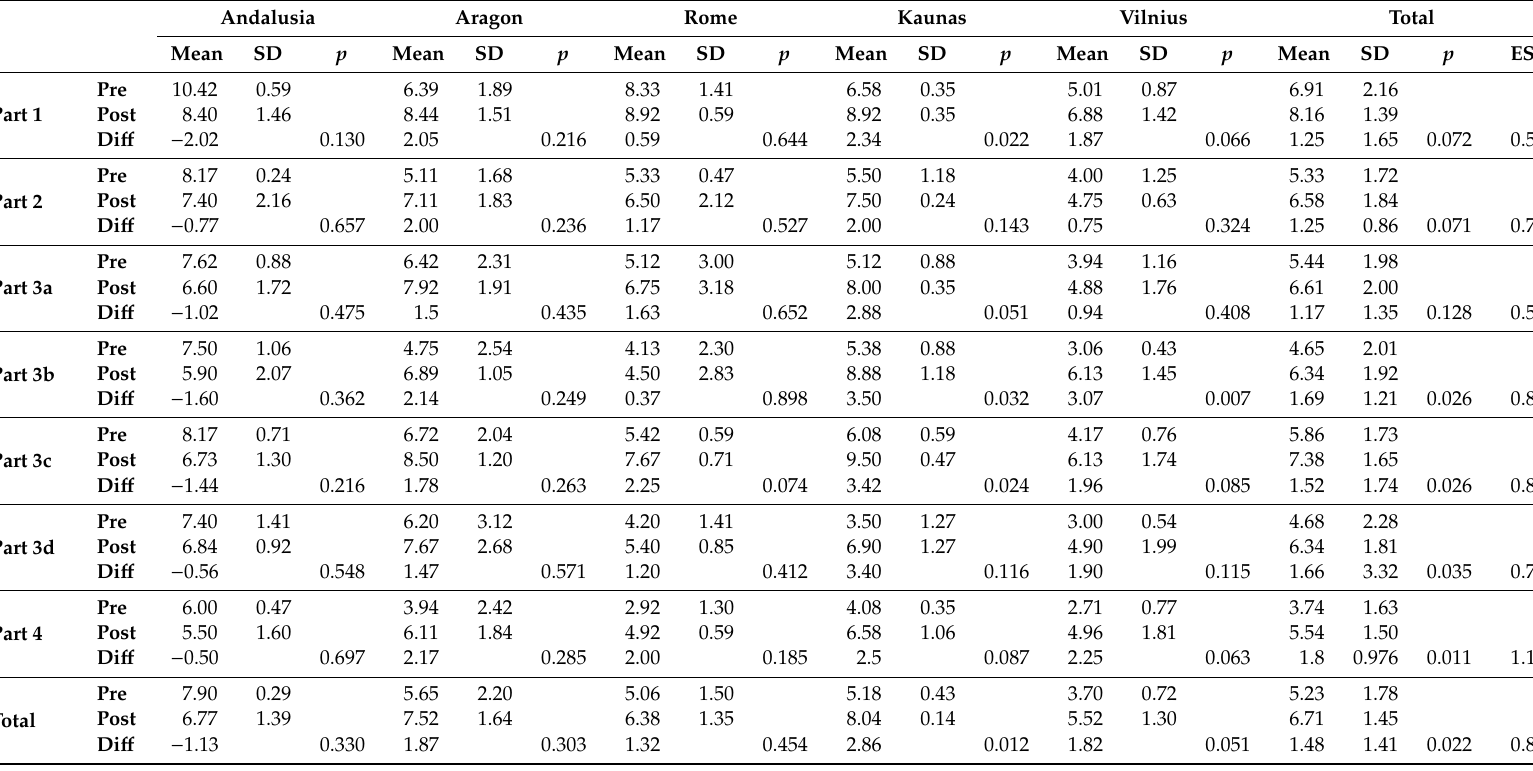
Table 1. Mean scores of the Assessment of Chronic Illness Care (ACIC) survey subscales and total scale, before (pre) and after (post) implementation of the Integrated Multimorbidity Care Model (IMCM), by